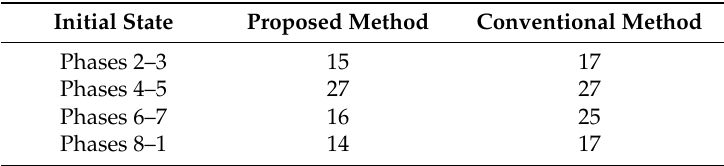
Table 4. The list of prediction limits for the ECMWF model (day) for forecasts from each MJO phase with the proposed and conventional